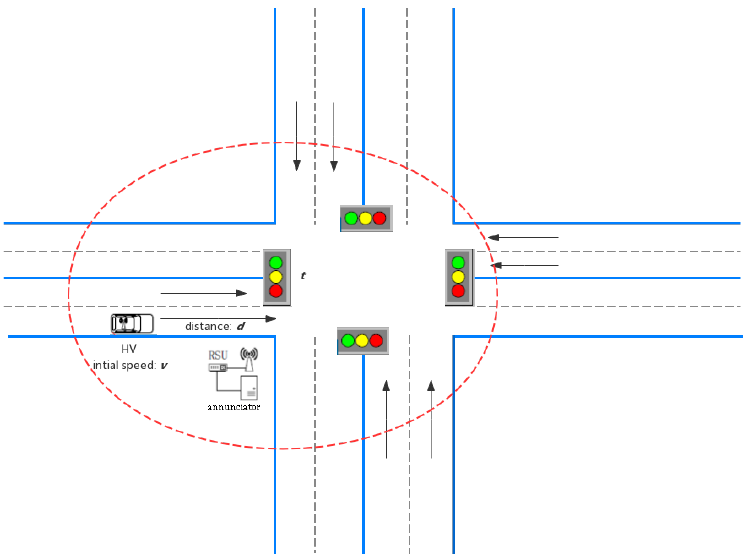
Figure 6. Green wave speed guide